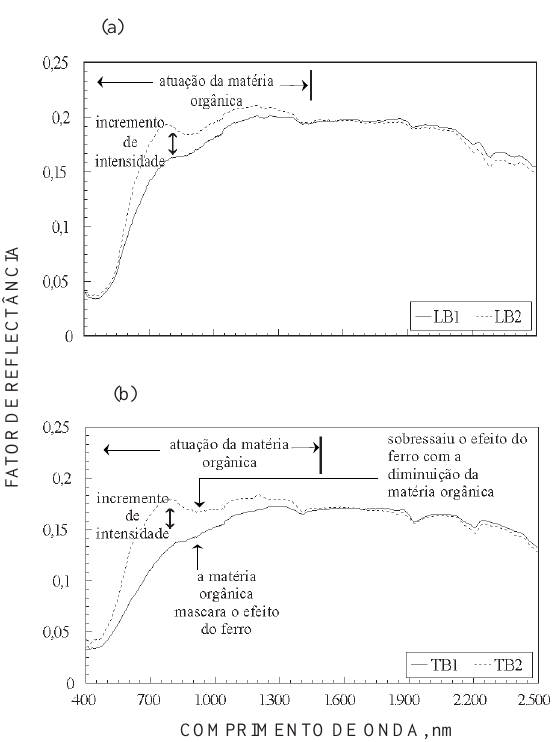
Figura 4. Curvas espectrais médias: (a) LB, Latossolo Bruno, (b) TB, Terra Bruna Estruturada. Designações: LB1, TB1: amostras da profundidade de 0-20 cm; LB2, TB2: amostras da profundidade de 40-60